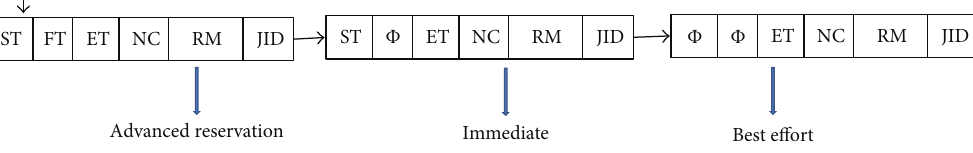
Figure 2: Representation of data structure as linked list of a